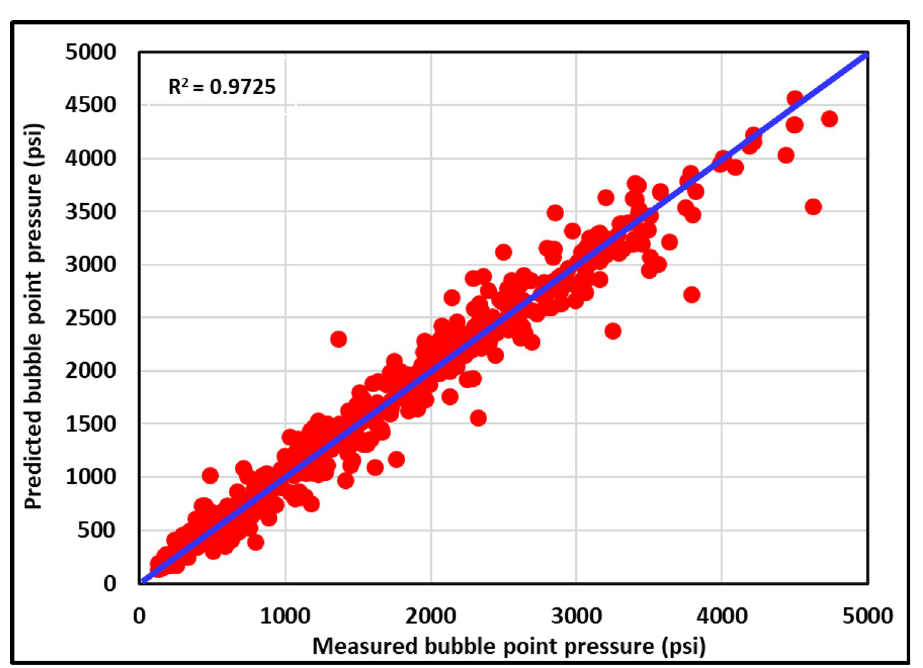
Fig 13. Cross-plot of training ANFIS model.